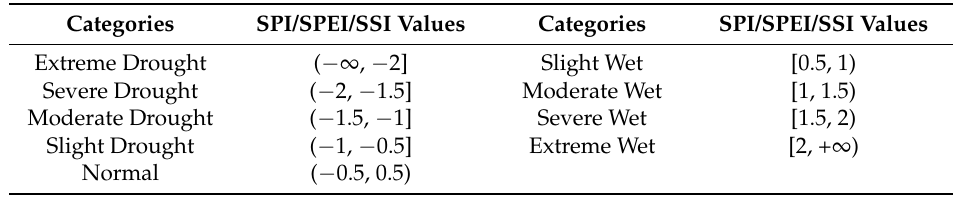
Table 2. The dry and wet classifications based on the Standardized Precipitation Index